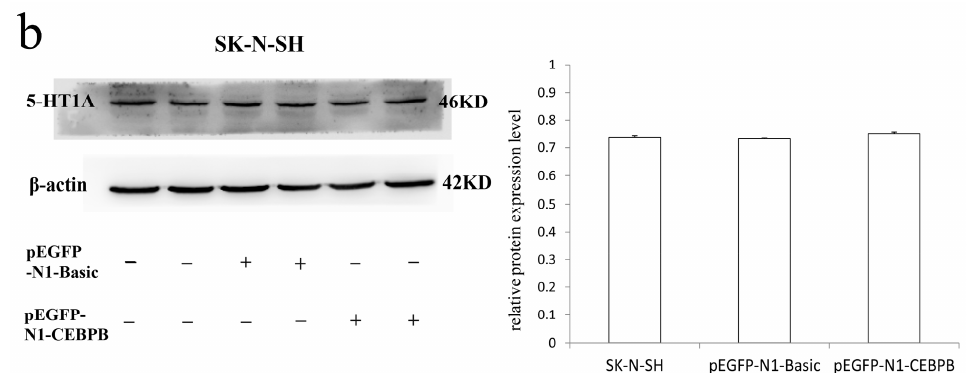
Figure 6. Insignificant inhibitory effect of CEBPB on the endogenous 5-HT1A receptors expression ( a ), ( b ), Western blot were performed with three groups including the two cell lines protein, the protein which were extracted from the cell transfected with the basic vector or the over-expressing CEBPB vector. The gray values for each sample were normalized using β -actin (relative protein expression and showed as the mean ± SD. Student’s t -test was used for differential comparison. The results showed that CEBPB did not inhibit endogenous 5-HT1A receptor expression in both cell lines.